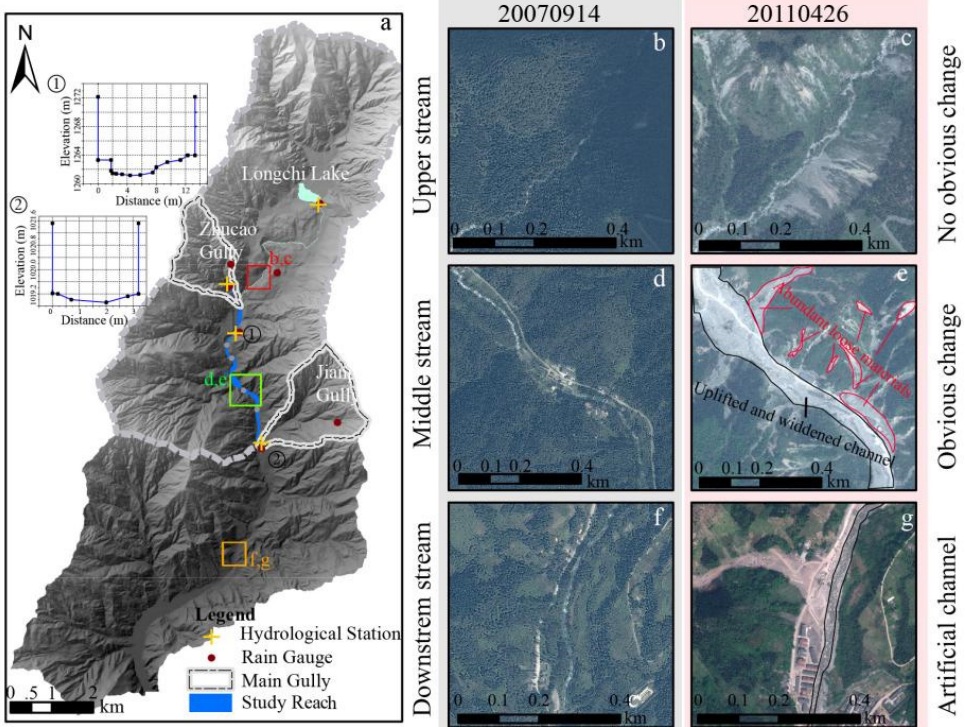
Figure 2. Boundary and characteristics of the study region: ( a ) shows the location of the study reach and the monitoring system in the study reach, including rain gauge and flow gauge. ( b – g ) are local remote sensing images before and after the debris flow occurred on 13 August 2010, which show the change in the channel in different periods. ( b , c ) showed a minor change in the upper stream, ( d , e ) showed the apparent change and abundant loose materials in the middle stream and ( f , g ) showed artificial channels in the downstream influenced by a human.